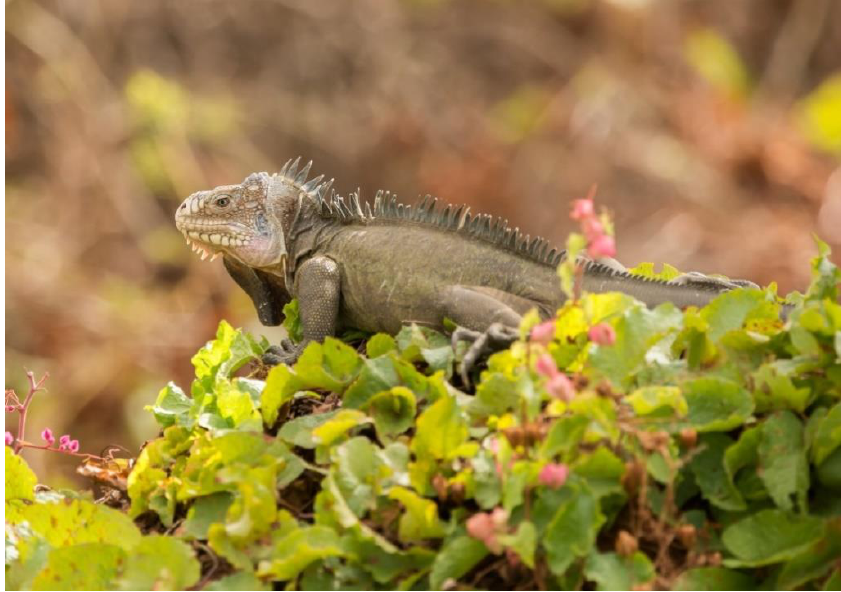
Figure 1. Adult male of I. delicatissima from St. Eustatius, Lesser Antilles (Photo: courtesy of Thijs van den Burg).